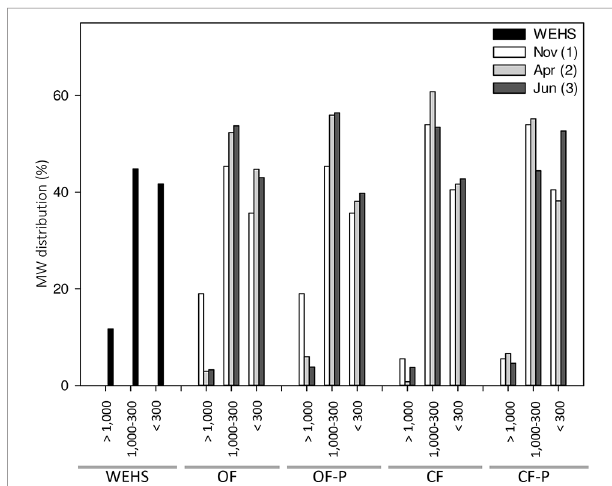
FIGURE 5 | Molecular weight (MW expressed in dalton) distribution of humic substances isolated from leachates collected from bare and planted soils at different sampling times. As control, MW distribution of water-extractable humic substances (WEHS) isolated from sphagnum peat (Novobalt, Lithuania) are also shown. Nov (1) refers to leachates sampled in November; Apr (2) refers to leachates sampled in April; Jun (3) refers to leachates sampled in June. OF and CF refer to leachates collected from bare soil columns; OF-P and CF-P refer to leachates collected from planted soil columns.